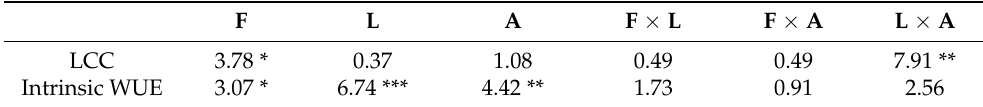
Figure 1. The mean leaf carbon content (LCC) and the intrinsic water use efficiency (intrinsic WUE) of trees, vines, herbs and ferns. ( a ) Leaf carbon content; ( b ) Intrinsic water use efficiency. Different letters indicate significant differences between different plant functional types ( p < 0.05). Boxes and error bars represent the mean values and standard errors. Table 1. The results of multi-factor ANOVA.